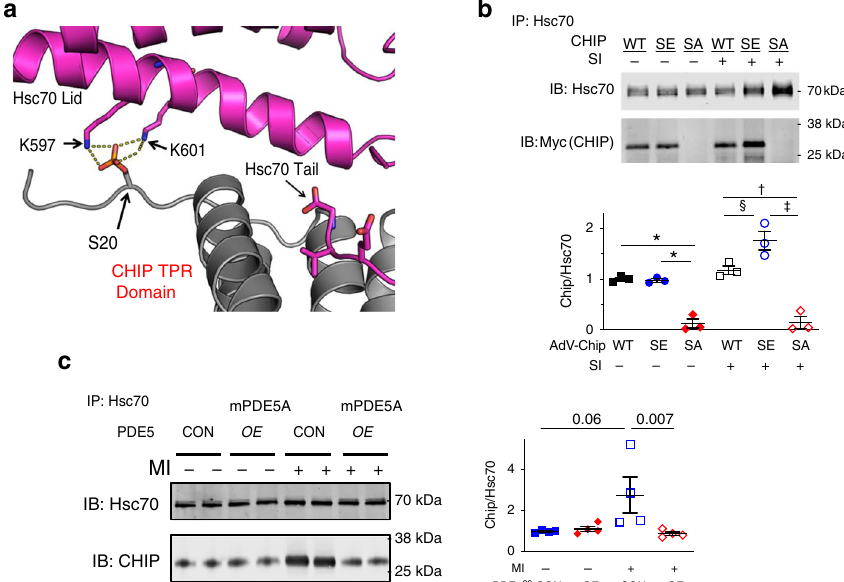
Fig. 6 PKG regulates CHIP-chaperone interaction and post-translational stability. a Structural model of binding region between Hsc70 lid motif and the TPR region in CHIP. The location of S20 in reference to opposing lysine residues K597 and K601 in Hsc70 is shown. b Upper: example immunoprecipitation using Hsc70 as bait, and detecting Myc-tagged WT, SE, or SA CHIP in both control and SI conditions. There is minimal Hsc70-CHIP co-precipitation when CHIP-SA is expressed. Lower: summary data, n = 3 biological replicates/group, 1WANOVA for each condition, Holms-Sidaks mct: * p = 1.2 × 10 − 4 , † 0.003, ‡ 0.0005, § 0.02. c Immunoprecipitation gels and summary data for Hsc70 and CHIP interaction in vivo with and without MI in mice with mPDE5 oe and littermate controls (CON). Hsc70 is bait, and antibody detection using CHIP and Hsc70. N = 4 biological replicates/group, Kruskal-Wallis test, Dunns mct. P values in fi gure. Source data are provided as a Source Data fi le. Individual data and mean ± SEM shown in each summary